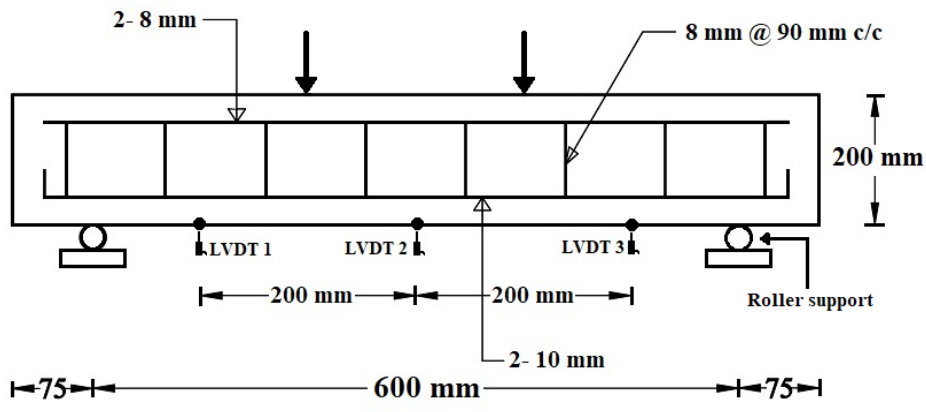
Figure 3. Four-point flexural test of the RC beams made with different percentages of IFSSA.